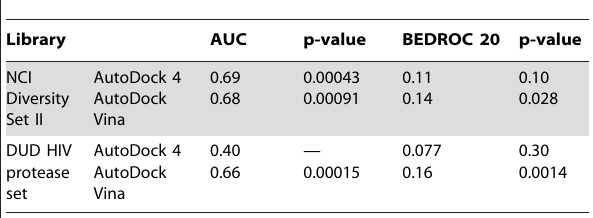
Figure 3. Based on the larger size of the compounds and greater number of rotatable bonds in DUD, it seemed possible that AD4 would possibly fail to even find the most favorable conformations consistently. As each compound was docked in 100 independent trials with AD4, cluster analysis provided a way to analyze variations in the reported conformations. The distribution of cluster sizes (Figure S2) shows that the docked conformation from DSII tended to fall into large clusters, while those from DUD did not. Small clusters indicate that AD4 had difficulty in consistently determining binding modes for the larger compounds in the DUD library.